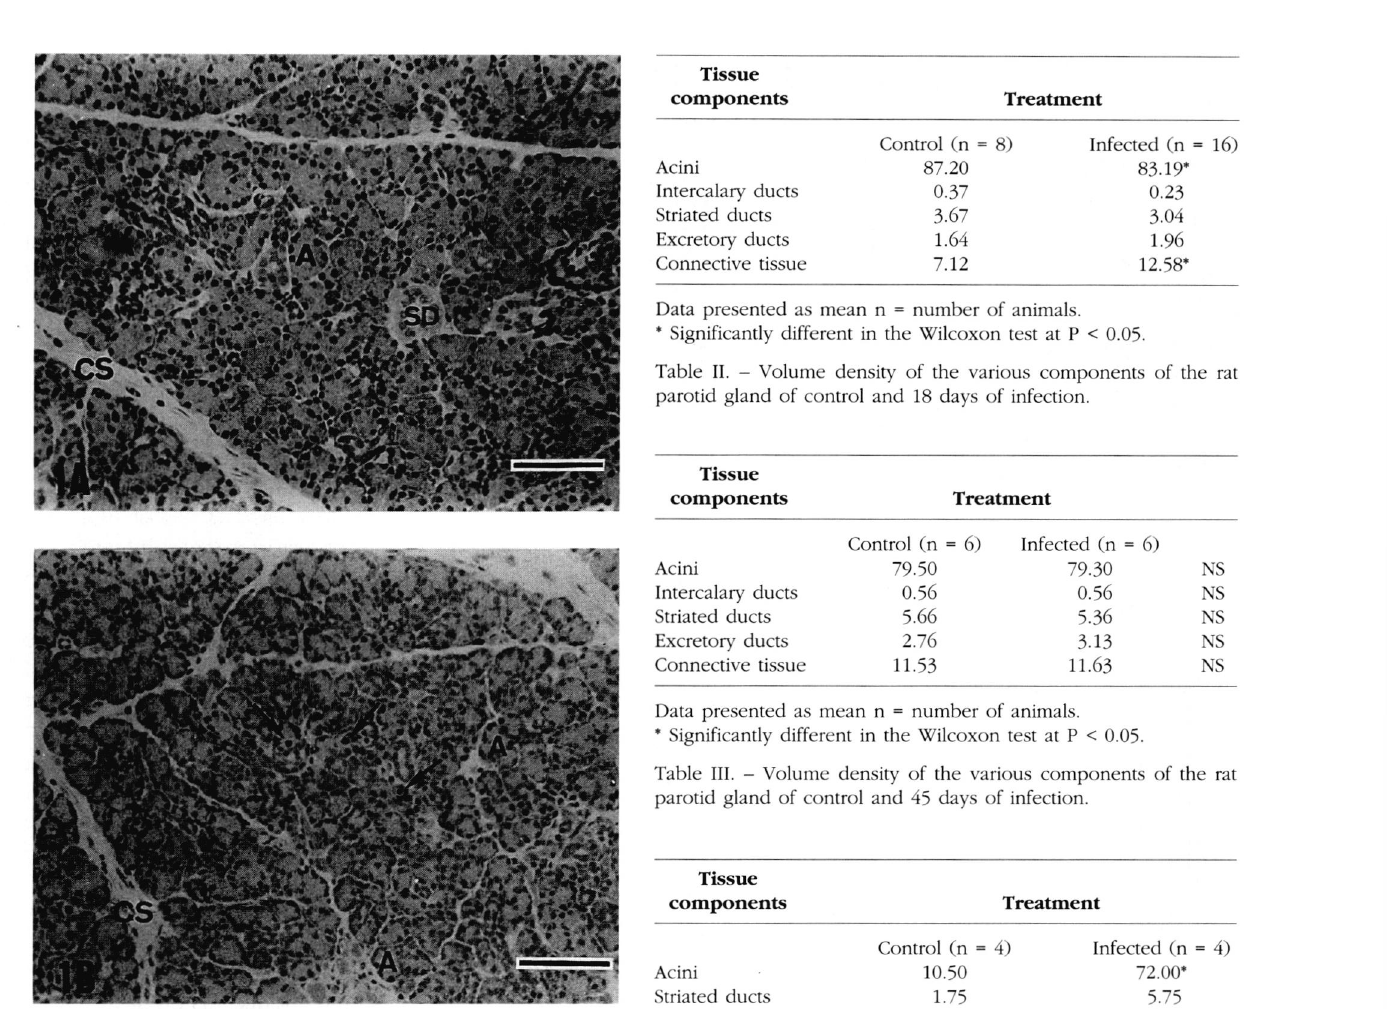
Fig. 1. - Sections of control and 18 day infected rats treated with colchicine. (a) Control, (b) Infected. Note reduction in size of acinar cells. Mitosis (arrows). Acini (A); Striated duct (SD); Connective stroma (CS). Domi- nicci. Bar: 50 urn.